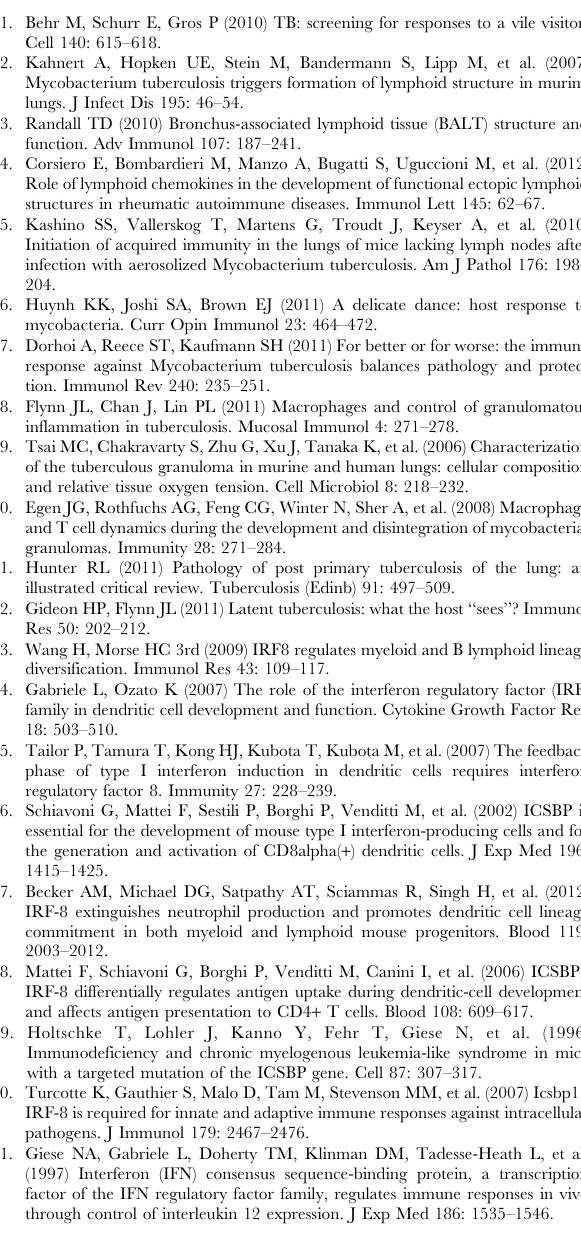
Figure S3 B lymphocytes in pulmonary granulomas of Mtb -infected IRF-8 2 / 2 vs. WT-B6 mice. Infected mice were euthanized respectively at 15 and 30 days p.i., when the pulmonary tissues were processed and sections were subjected to IHC with Abs for the lymphocytic marker B220.